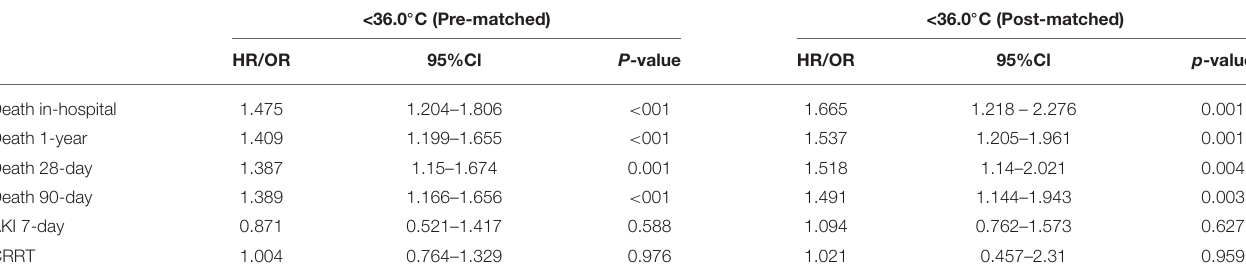
TABLE 3 | Multivariable cox regression and logistic regression analysis for hypothermia.